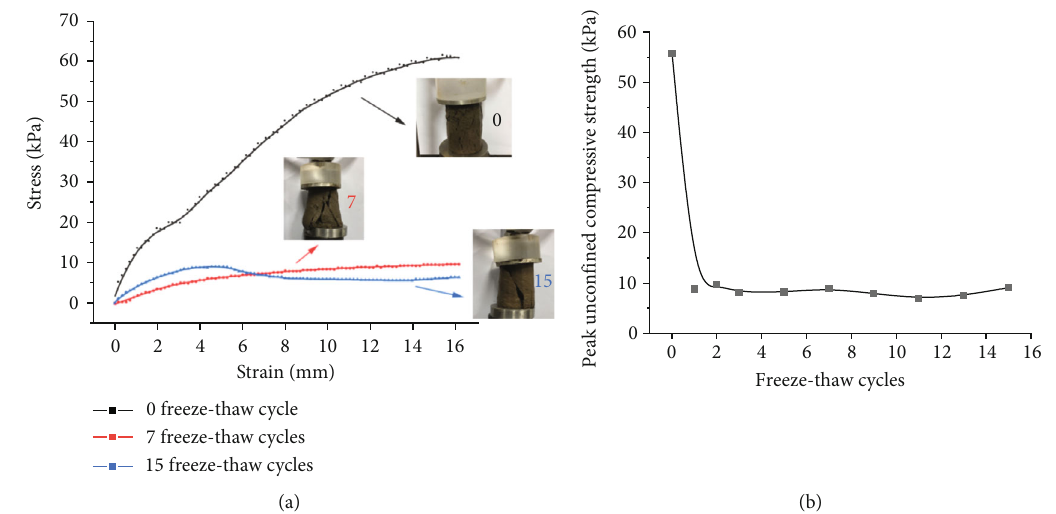
Figure 2: Relationship between the uncon fi ned compressive strength and the freeze-thaw cycles: (a) stress-strain behavior and (b) peak strength versus freeze-thaw